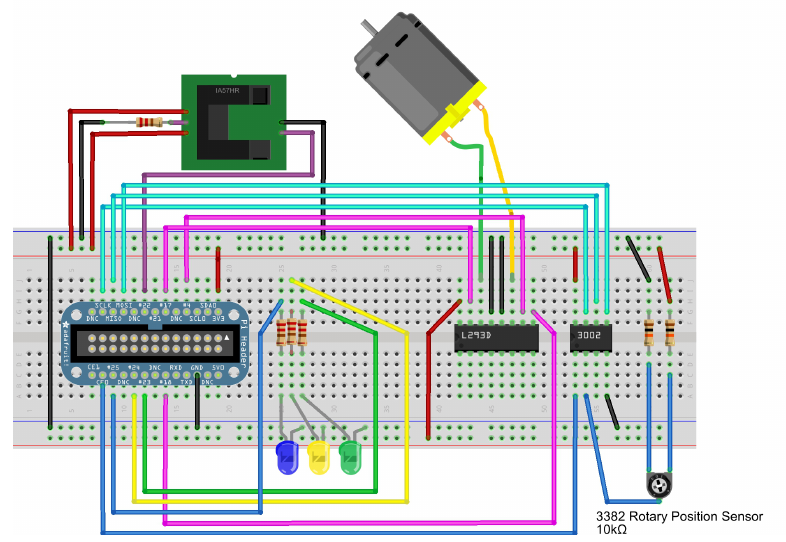
Figure 2. Breadboard Schematic.